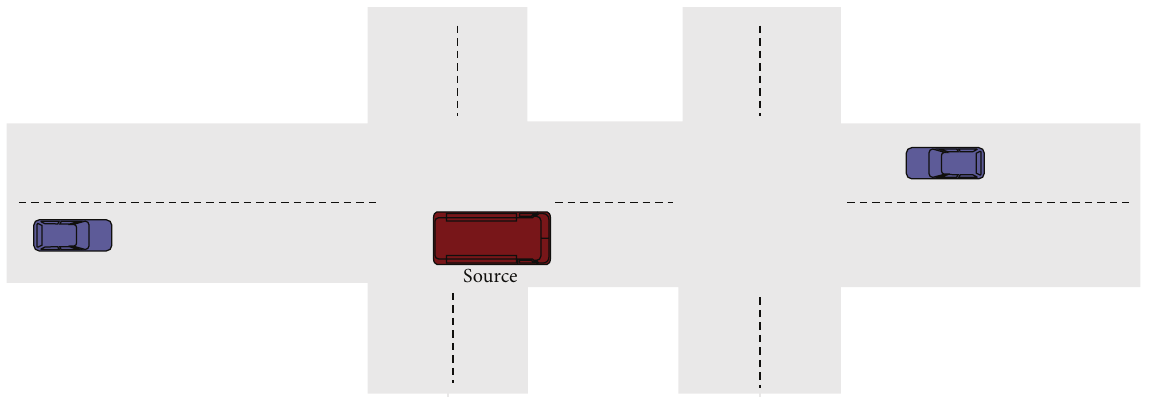
Figure 5: Sparse